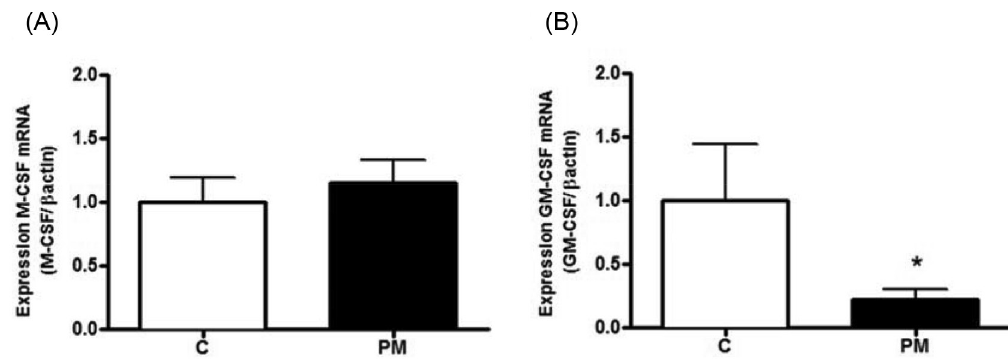
FIGURE 1 - Expression of M-CSF ( A ) and GM-CSF ( B ) mRNA in peritoneal cells. Results are expressed as the mean and standard deviation for the control (C) (n = 6) and protein-malnourished (PM) (n = 6) groups. * Significant difference between the PM and control groups (p ≤ 0.05).